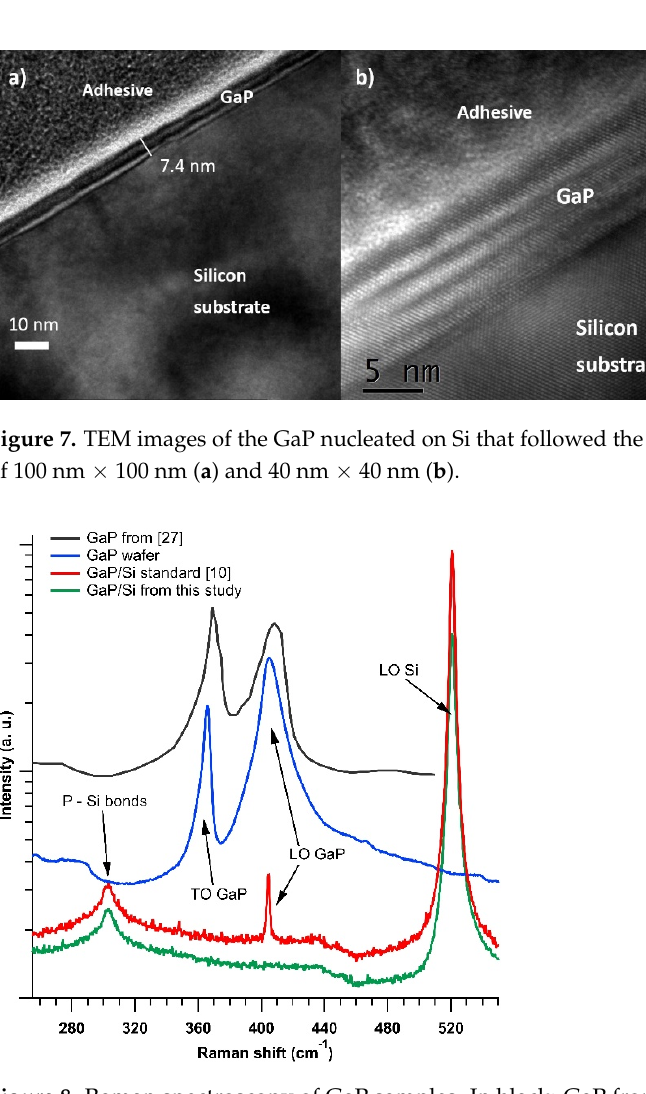
5 of 100 nm × 100 nm ( a ) and 40 nm × 40 nm ( b ).